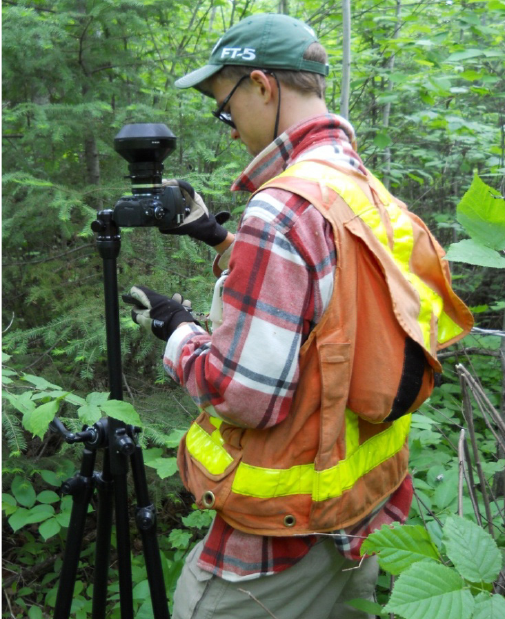
Figure 5. Setup of camera and lens system in a